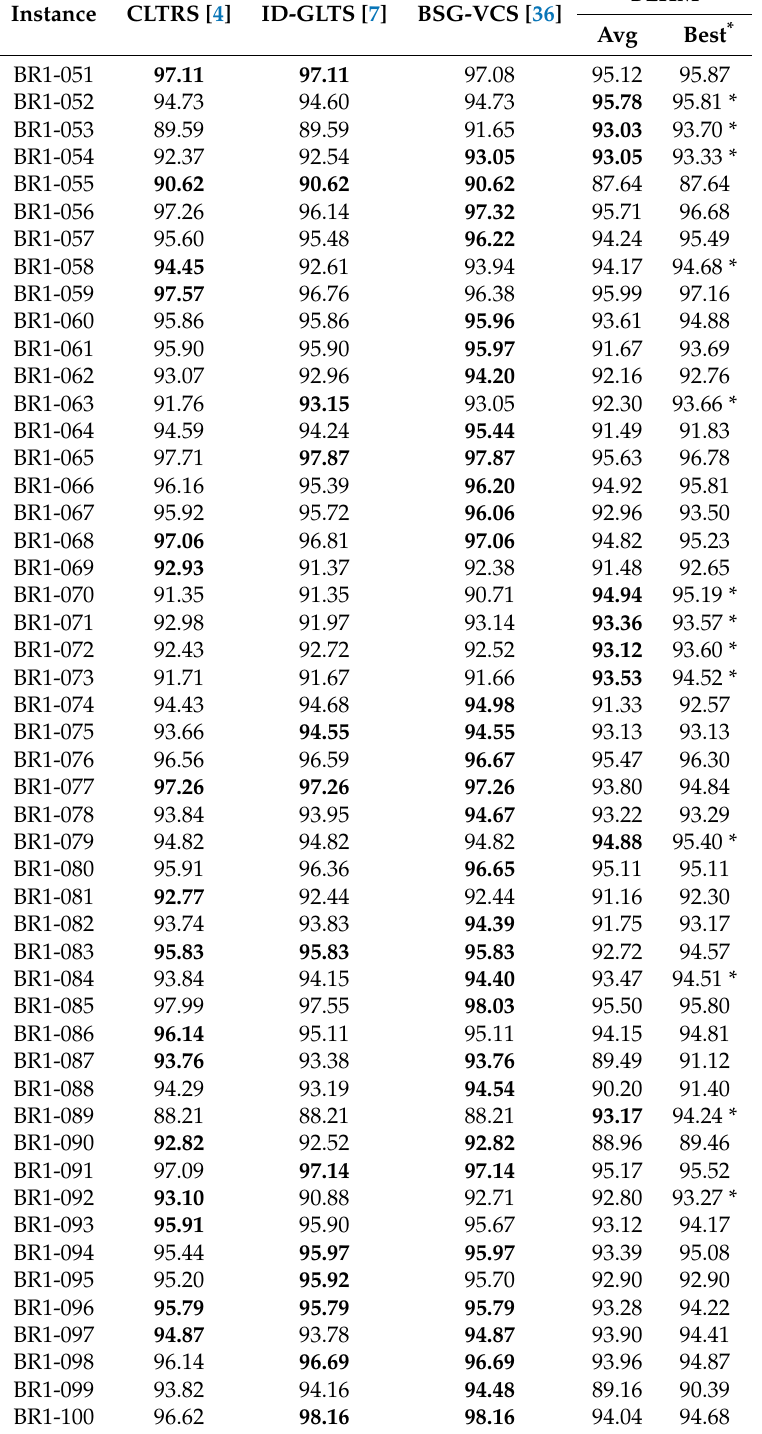
Table 2. Results for group BR1